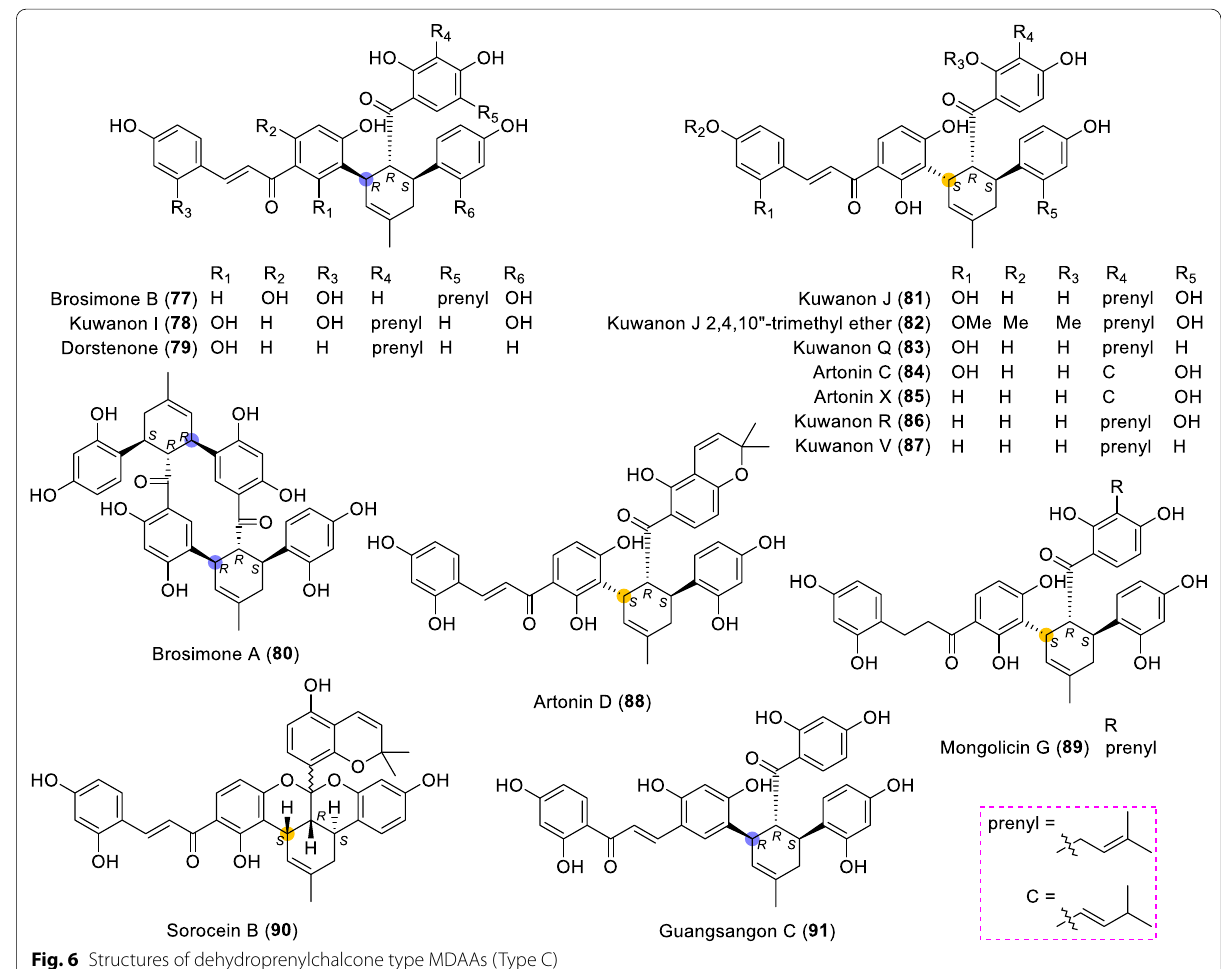
Fig. 6 Structures of dehydroprenylchalcone type MDAAs (Type